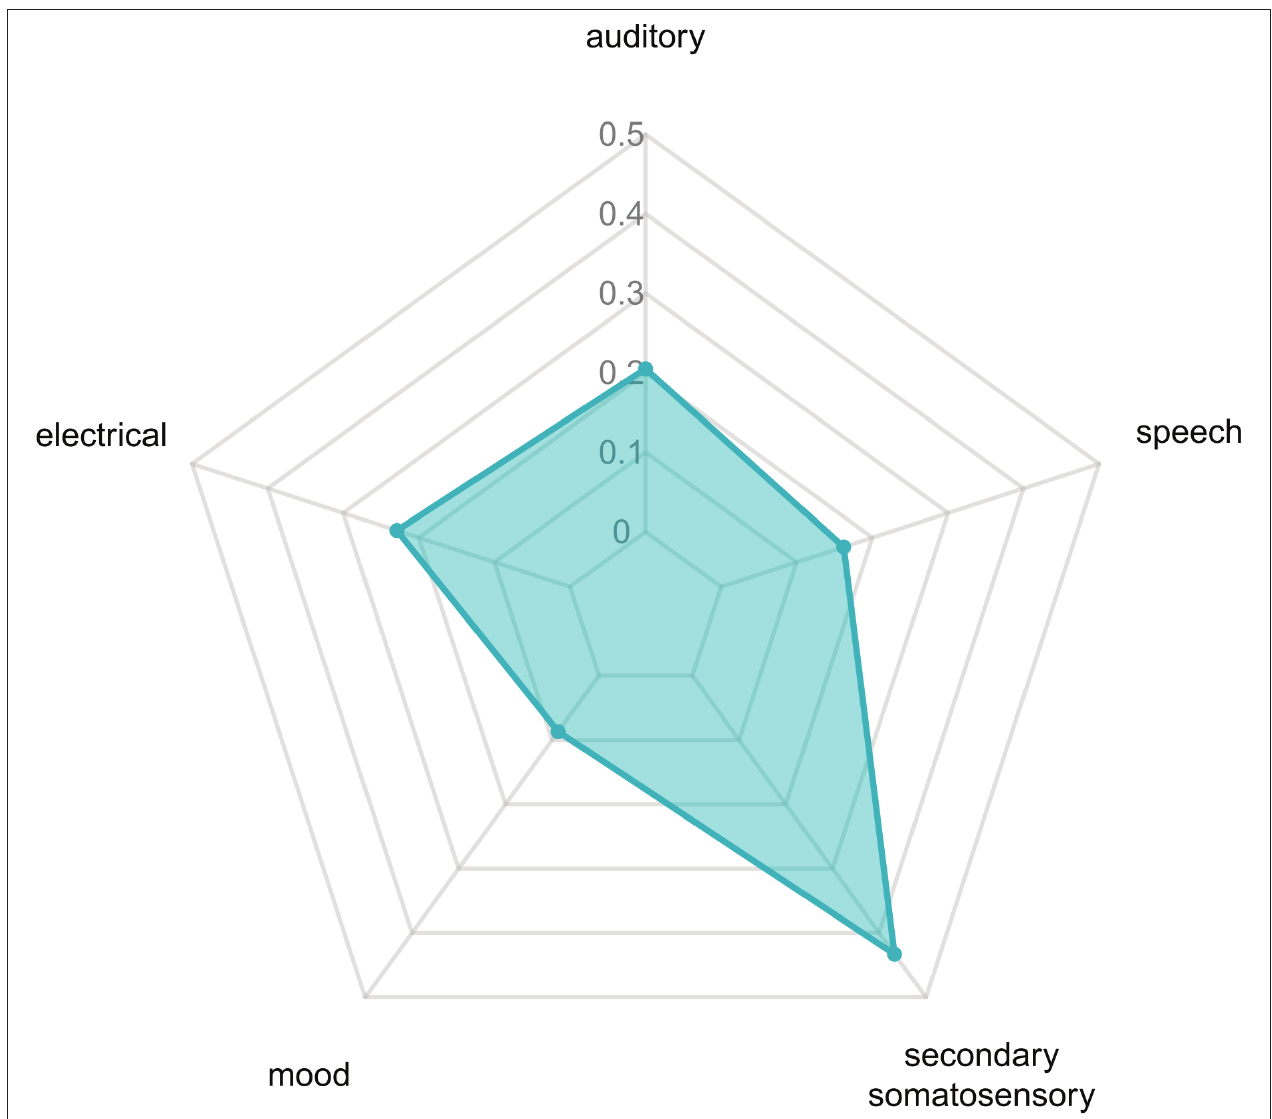
FIGURE 4 | The relevant decoded functions of acupuncture at